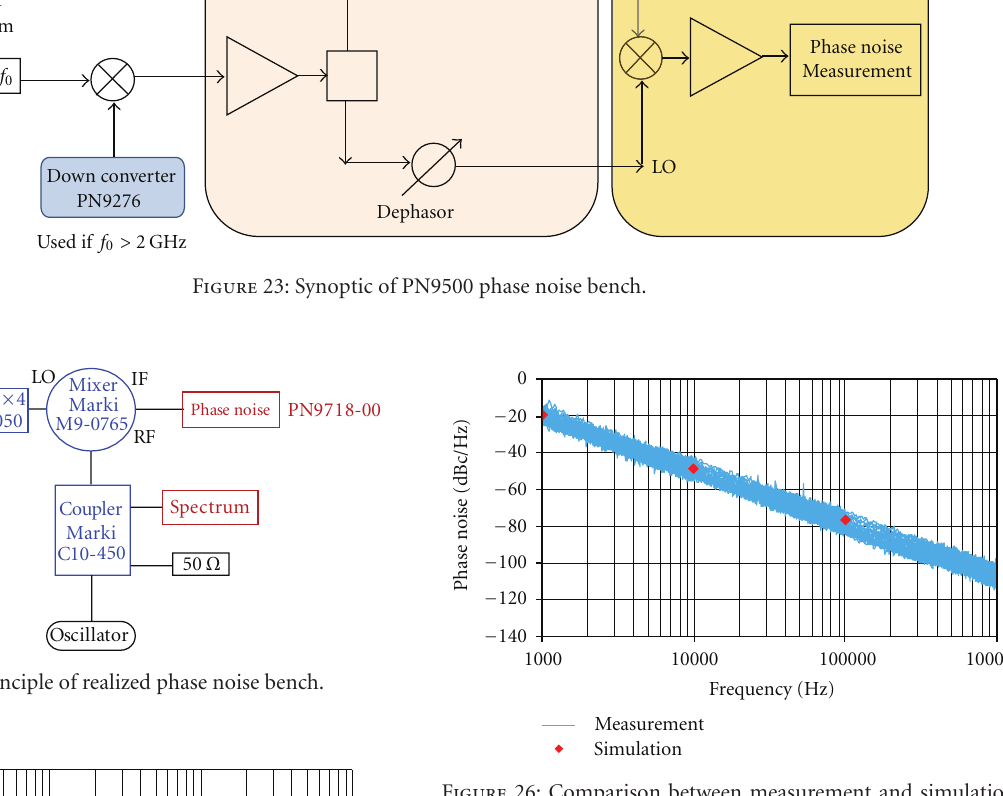
Figure 26: Comparison between measurement and simulation of oscillator phase